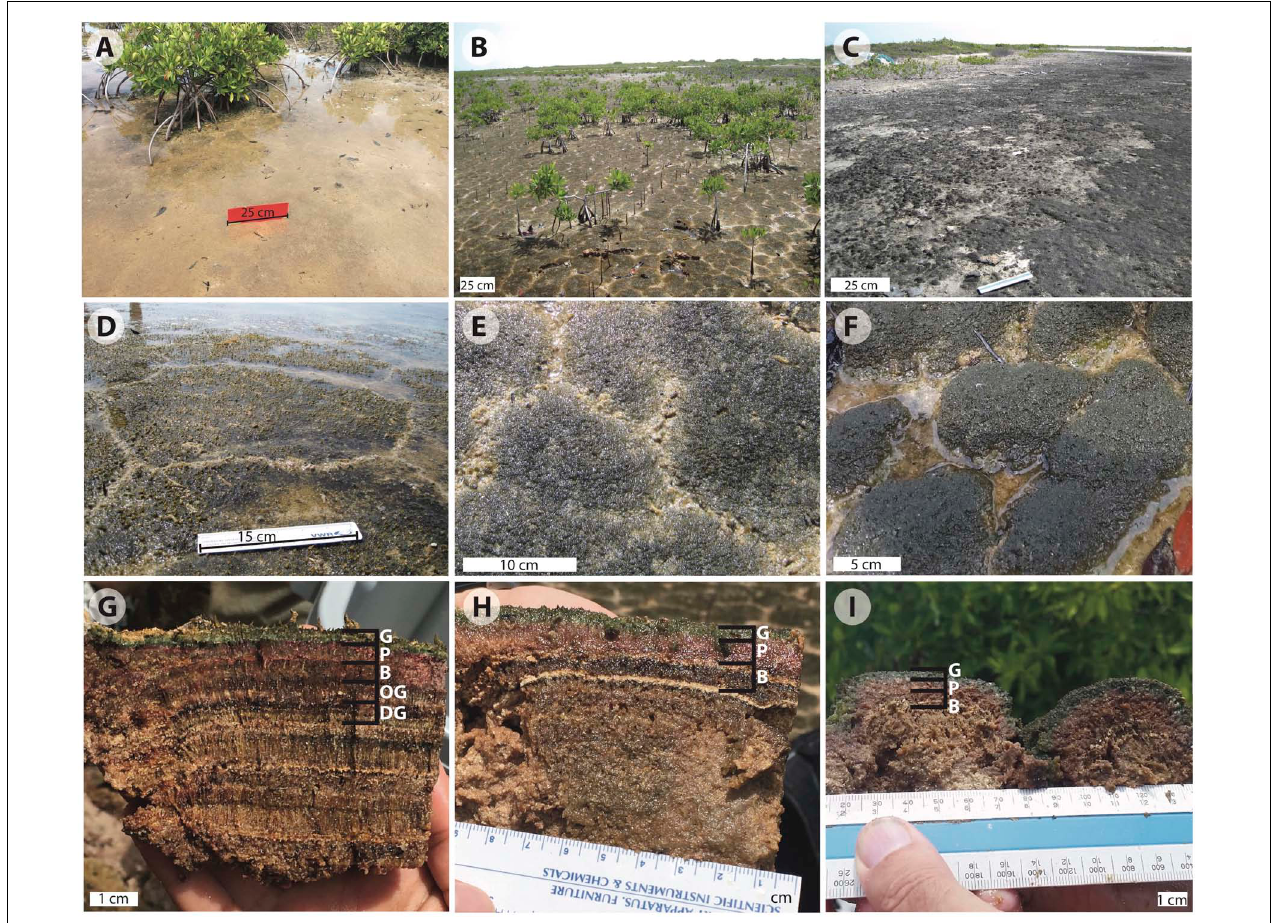
FIGURE 2 | Images of Little Ambergris Cay microbial mats: (A) flat mat; (B) polygonal mats (online image reprinted with permission, retrieved http://gomeslab.weebly.com) (C) blister mats; (D) polygonal mat site CC2; (E) polygonal mat site CC1; (F) polygonal mat site F6; (G) cross-section of polygonal mat CC2; (H) cross-section of polygonal mat CC1; (I) cross-section of polygonal mat F6. The cross sections in (G–I) show the G, green; P, pink; and B, brown layers in mats CC2, CC1, and F6, respectively. Image G also shows the OG, olive-green and DG, dark-green pigment-poor layers in CC2. Note the vertically oriented filamentous layers in the B, OG, and DG layers and layers below. Judging from Hurricane Irma in 2017, we suspect that the thin ooid laminae visible in (H) record earlier hurricanes that washed oolitic sand into the island